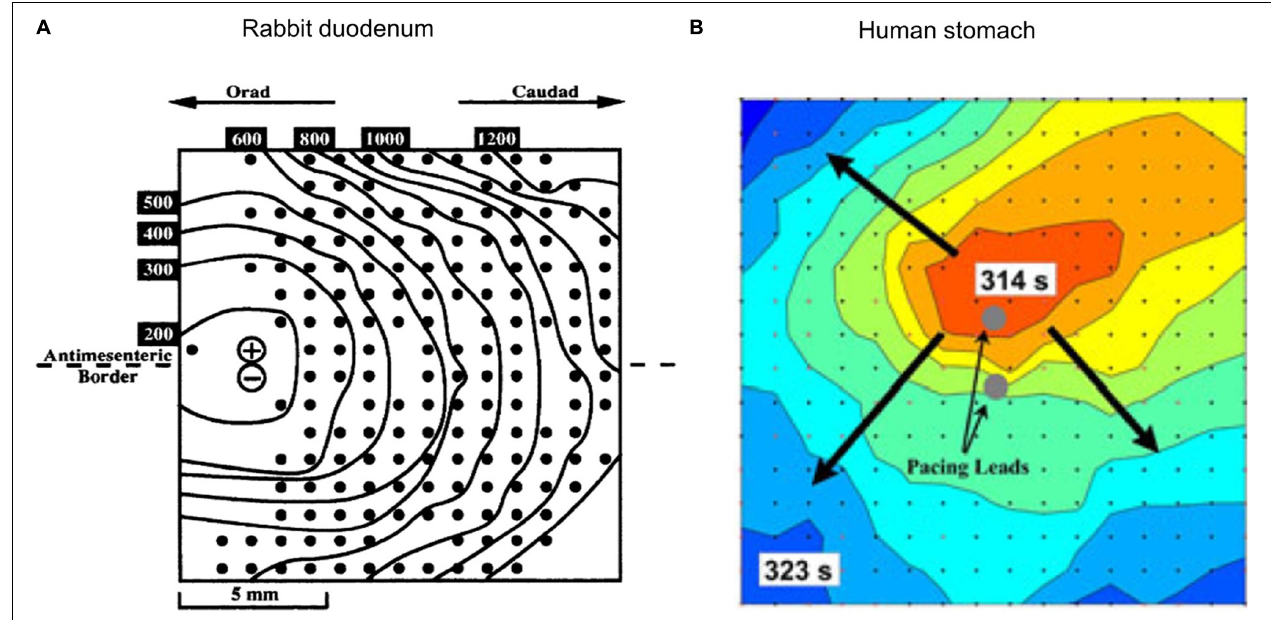
FIGURE 2 | Combining HR mapping and pacing techniques allows the slow wave response to be tracked and quantified. (A) Pacing on the left side of a rabbit duodenum preparation and resultant propagation across the mapped area, (B) Pacing from the center of a 60 mm 2 electrode array (red is early activation, and blue is late activation), and corresponding radial propagation from the pacing leads (gray circles). Modified from Lammers et al. (1993) and Alighaleh et al. (2018).